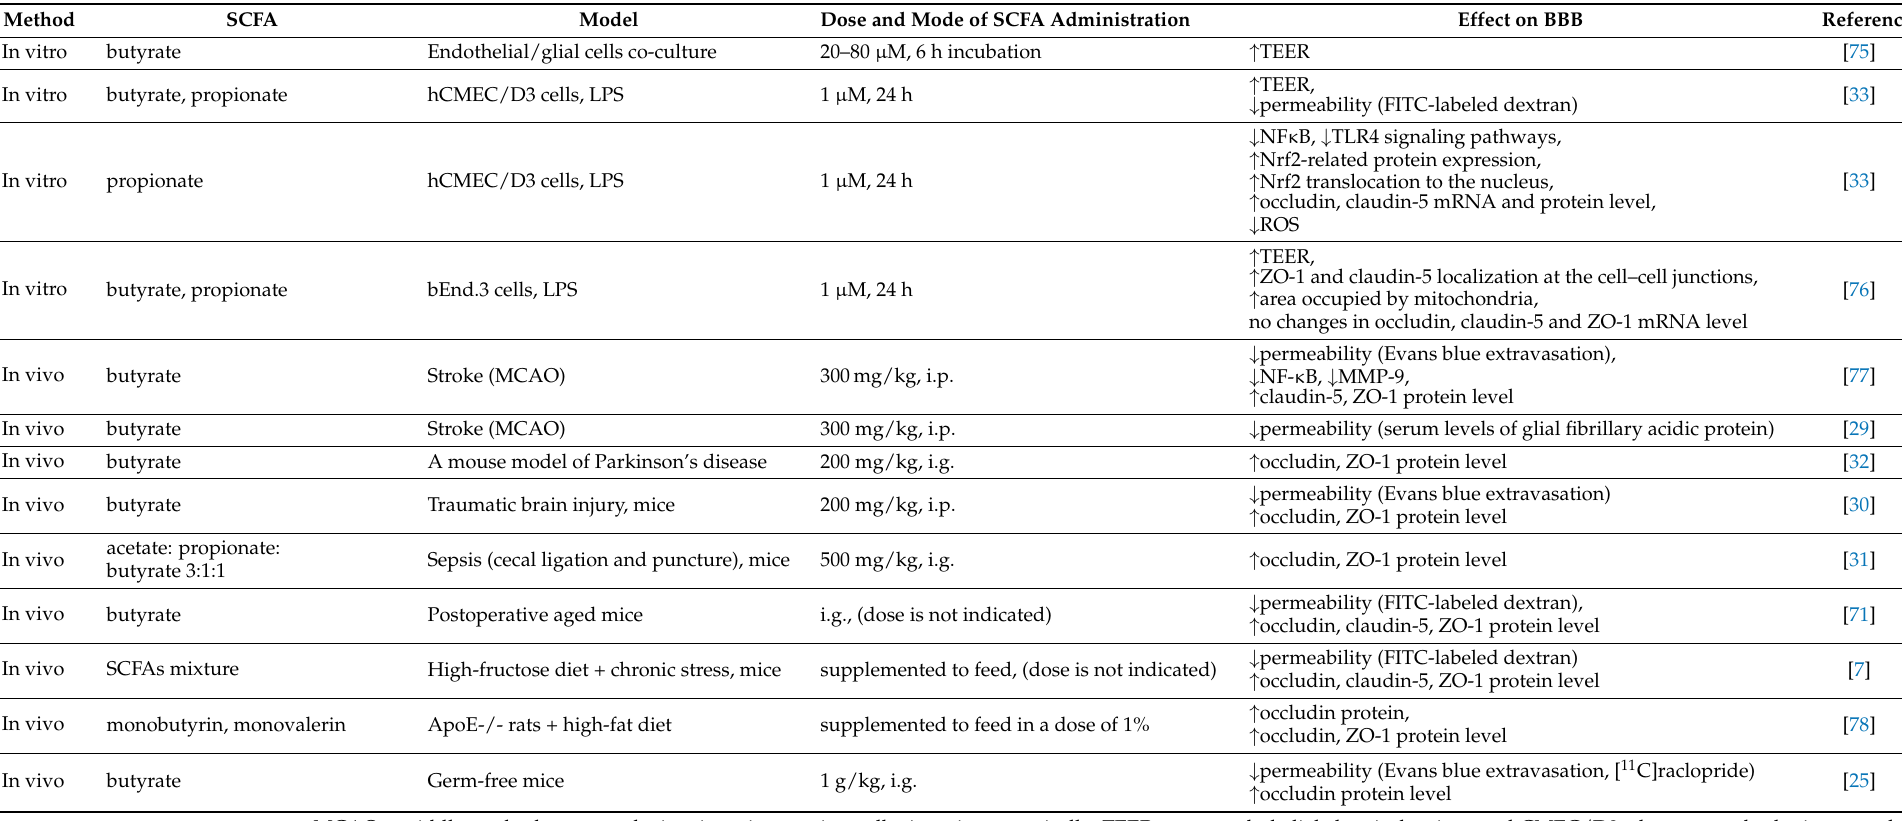
Table 1. SCFA effects on the BBB in in vitro and in vivo